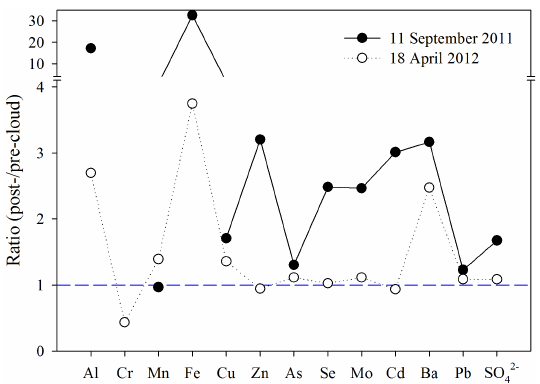
Figure 10. The increments of trace element solubility and sulfate concentrations by cloud processing. It is plotted as the ratios of post- to pre-cloud solubility or concentrations. Ratio > 1 (blue dashed line) indicates an increase in solubility or